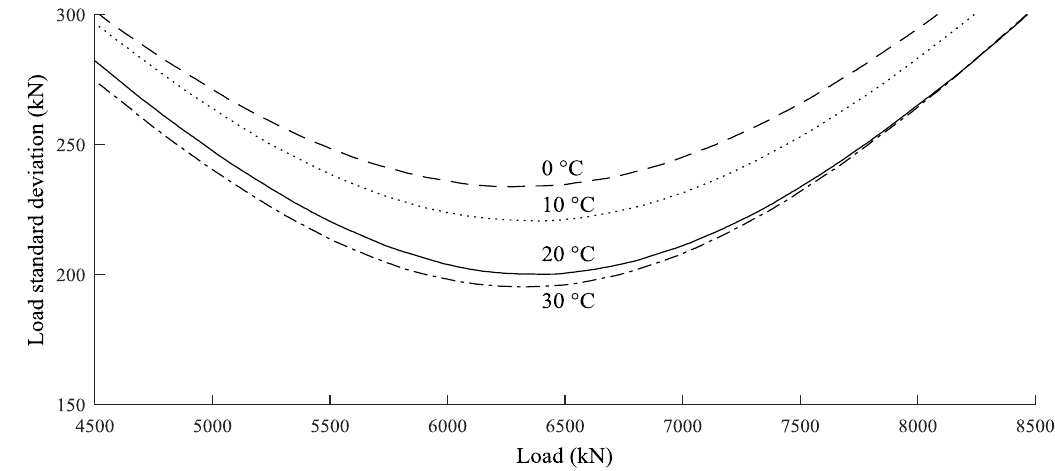
Figure 8. Standard deviation of load on cable 5TN estimated by Equation (17). Table 2. First 16 frequencies in Hz obtained with FFT.